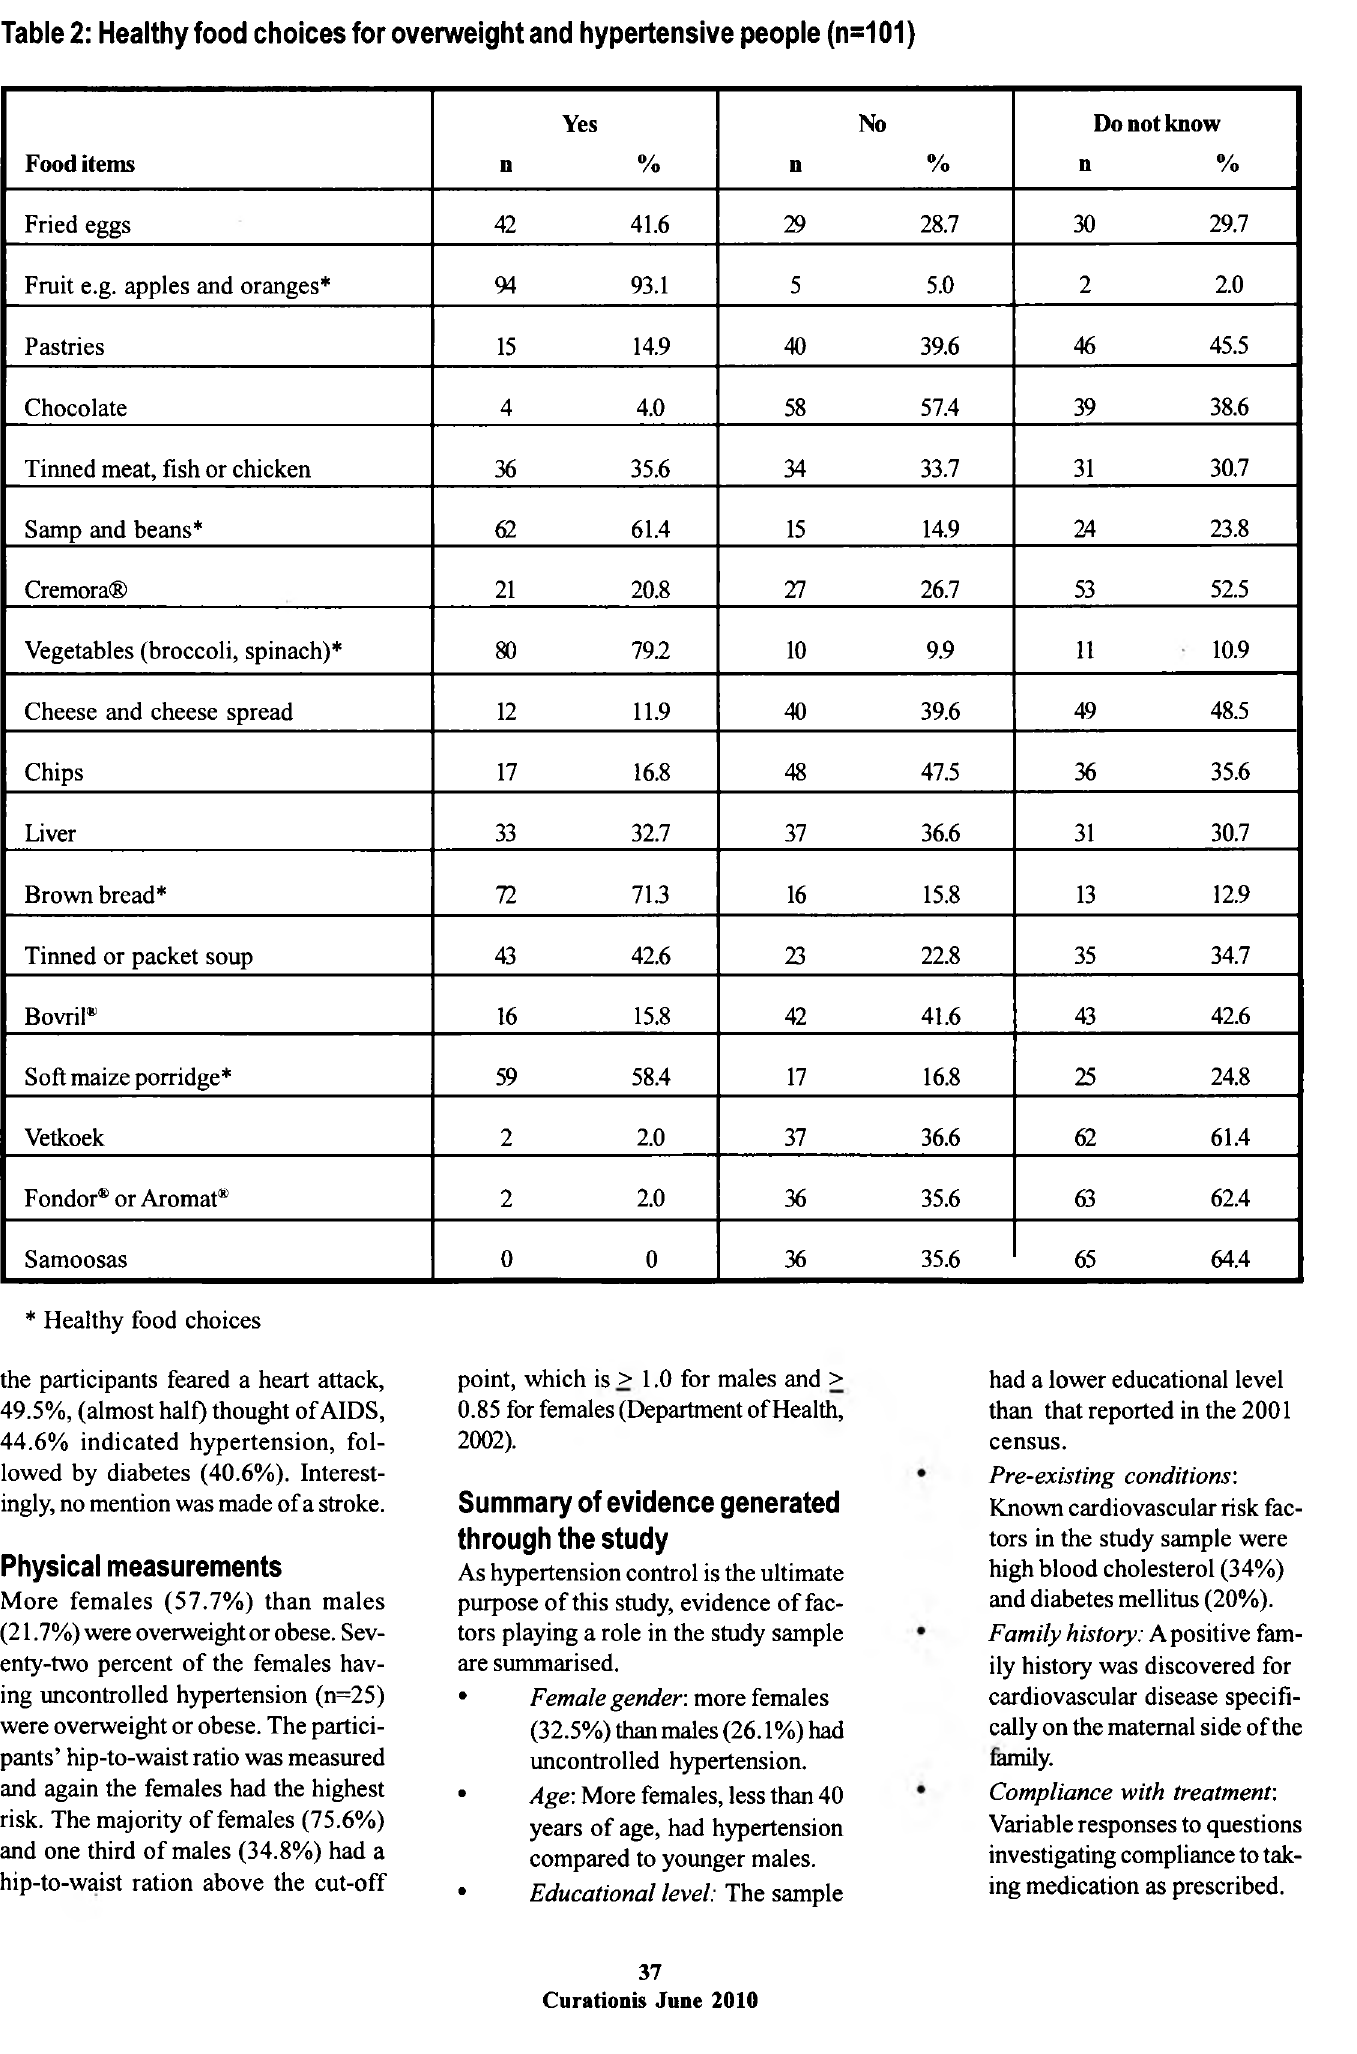
Table 2: Healthy food choices for overweight and hypertensive people (n=101)